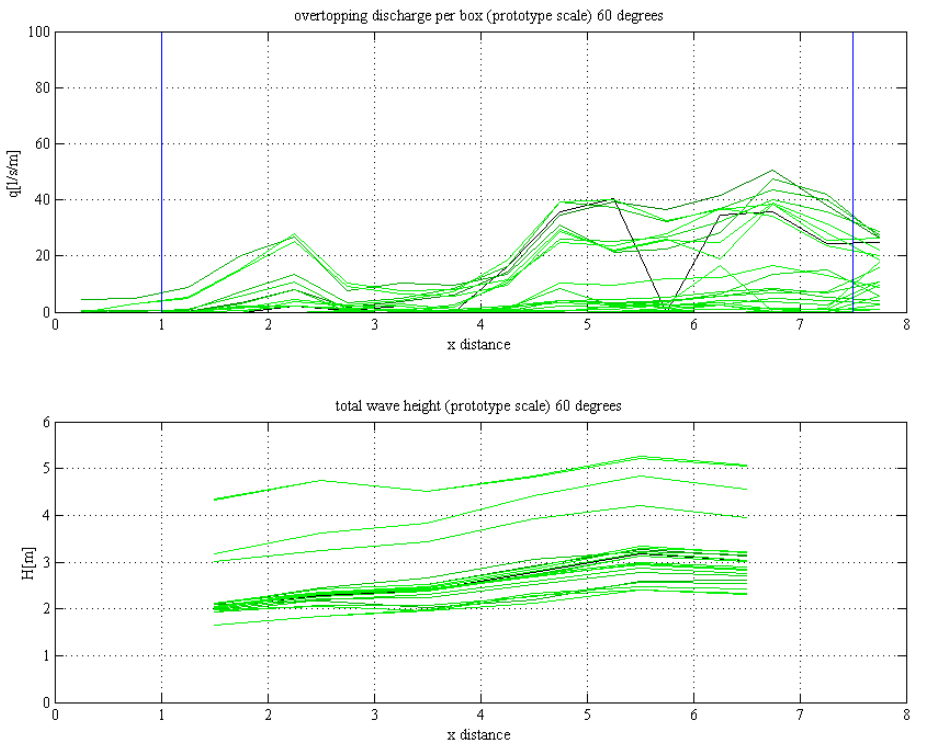
Figure 8. Overtopping discharge per box along the vertical quay and the total wave height for direction 60°.